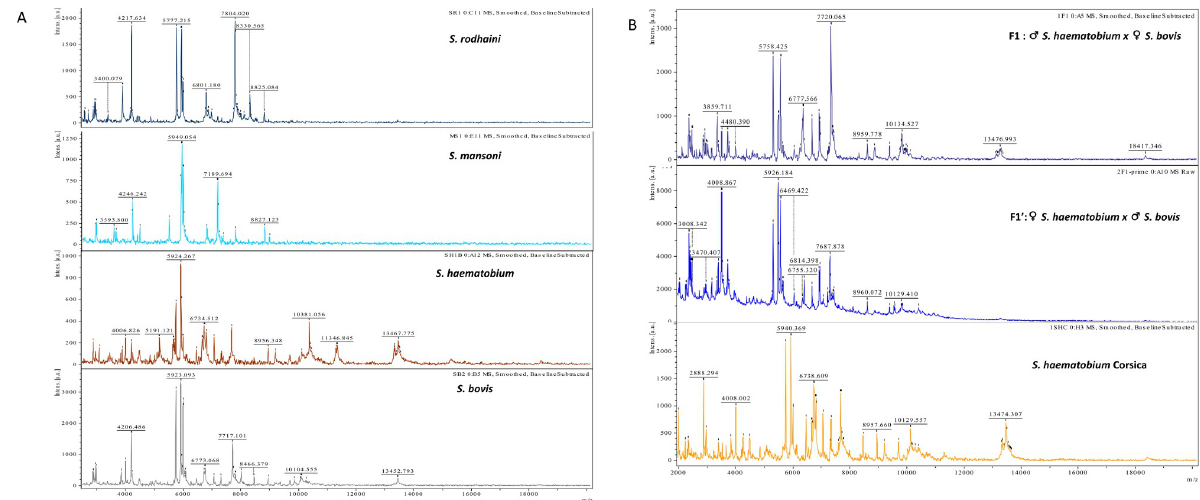
Fig 1. Representative spectra of cercariae. Panel A: The four species of Schistosoma : S . rodhaini , S . mansoni , S . haematobium and S . bovis . Panel B: S . haematobium x S . bovis F1 and F1’ laboratory reared hybrids, S . haematobium x S . bovis Corsican hybrids. Smoothed spectra with baseline substracted. The m/z values are expressed in Da and the intensity of spectra are reported in arbitrary unit (a. u.).